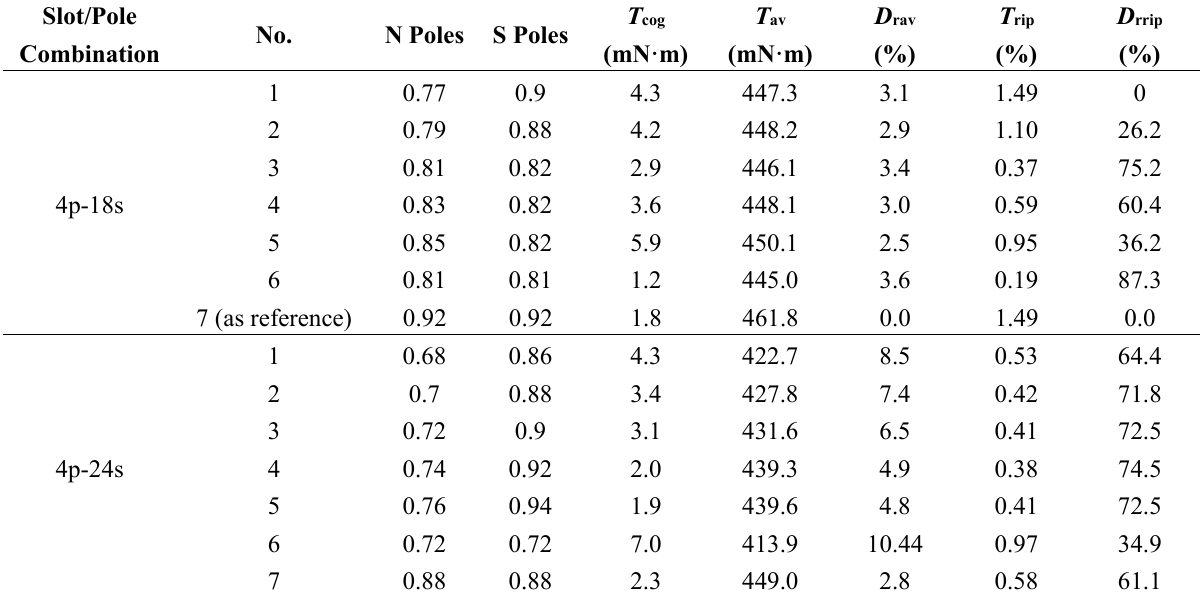
Figure 7. The trend of cogging torque with different magnetic-pole embrace: ( a ) 4p-18s PMSM; ( b ) 4p-24s PMSM. Table 7. Torque characteristics with combinations of embrace.